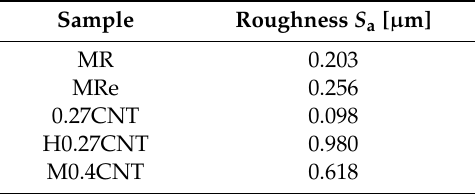
Table 3. Surface roughness of the native material and deposited coatings.